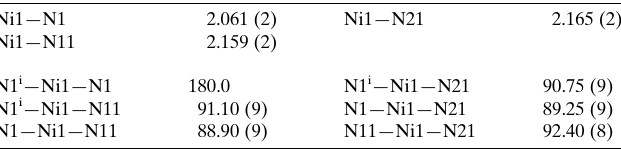
Table 1 Selected geometric parameters (A˚ , (cid:4) ).